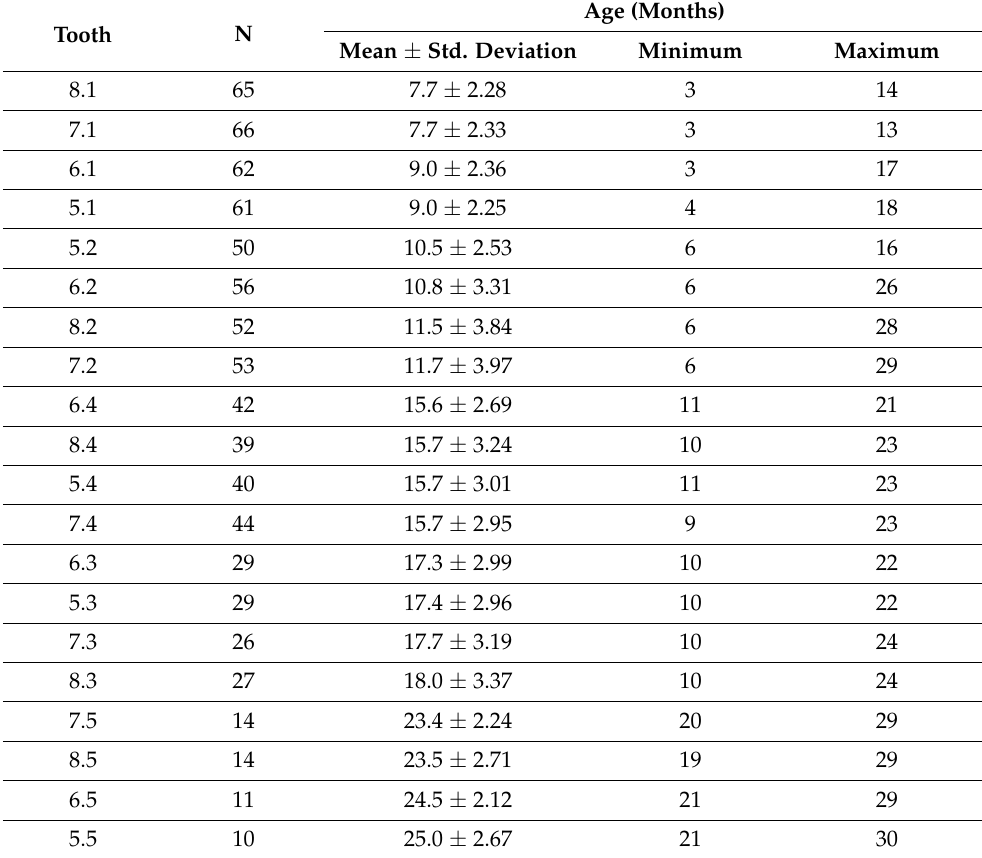
Table 2. The age and sequence of eruption of each primary